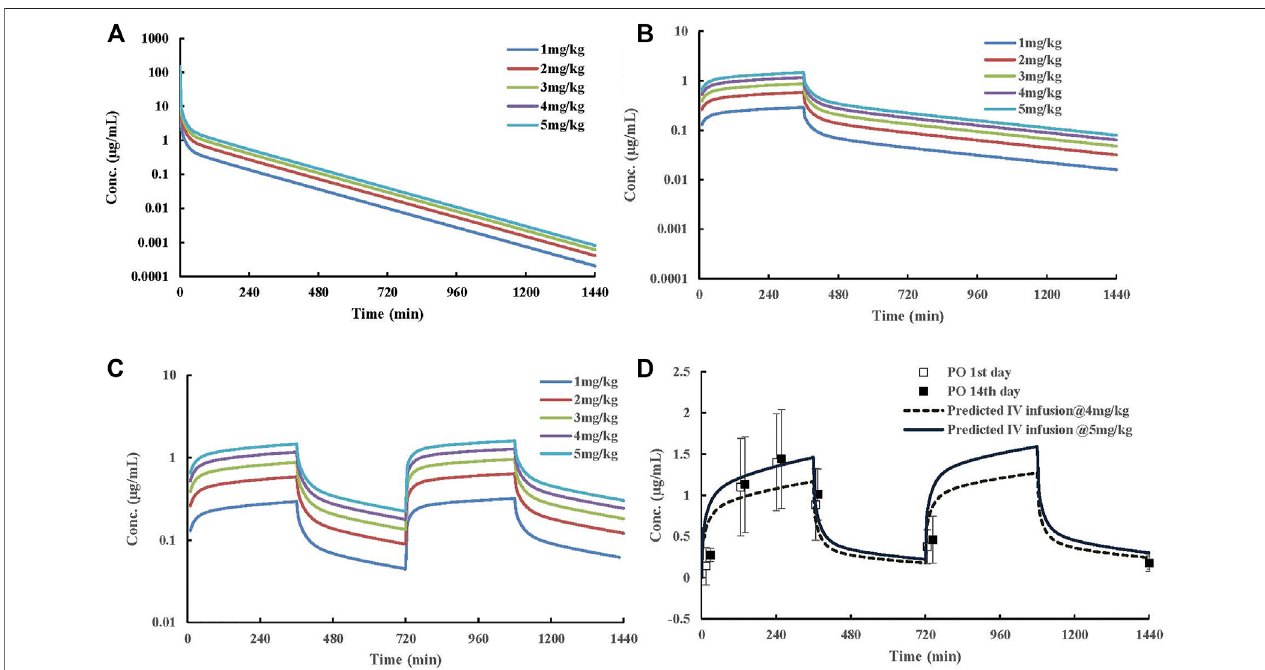
FIGURE 5 | Predicted dose-dependent exposure of ST-246 in a virtual typical Chinese after IV, 6 h IV infusion QD, and 6 h IV infusion BID to capture the clinically relevant PK curves after oral dosing at 600 mg. (A) predicted human PK pro fi les post IV dosing; (B) predicted human PK pro fi les post 6-h IV infusion QD; (C) predicted human PK pro fi les post 6-h IV infusion BID; (D) predicted human PK pro fi les post 6-h IV infusion BID at 4 and 5 mg/kg dosages and observed clinically relevant oral PK pro fi les at therapeutic dose (600 mg). Clinical data were obtained from the literature. The solid square represents plasma concentration from the 1st day, and the hollow square represents plasma concentration from the 14th day.